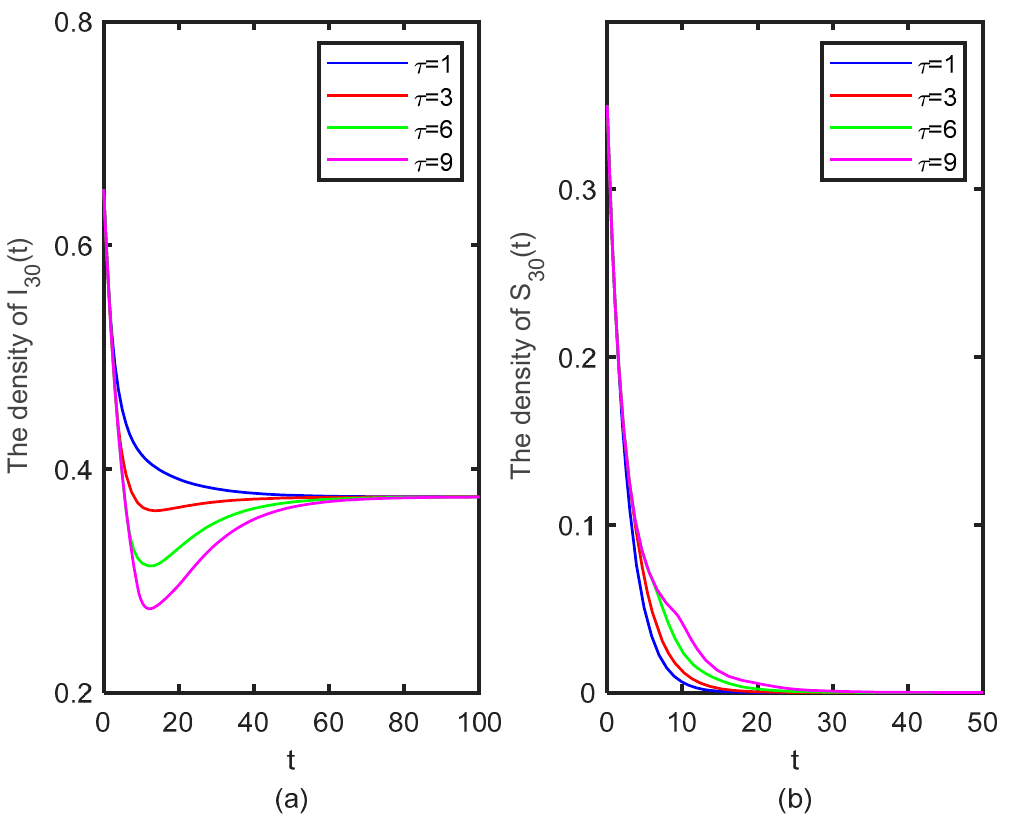
Figure 7. The densities of I 30 ( t ) ( a ) and S 30 ( t ) ; ( b ) for different time delays when R 0 > 1.